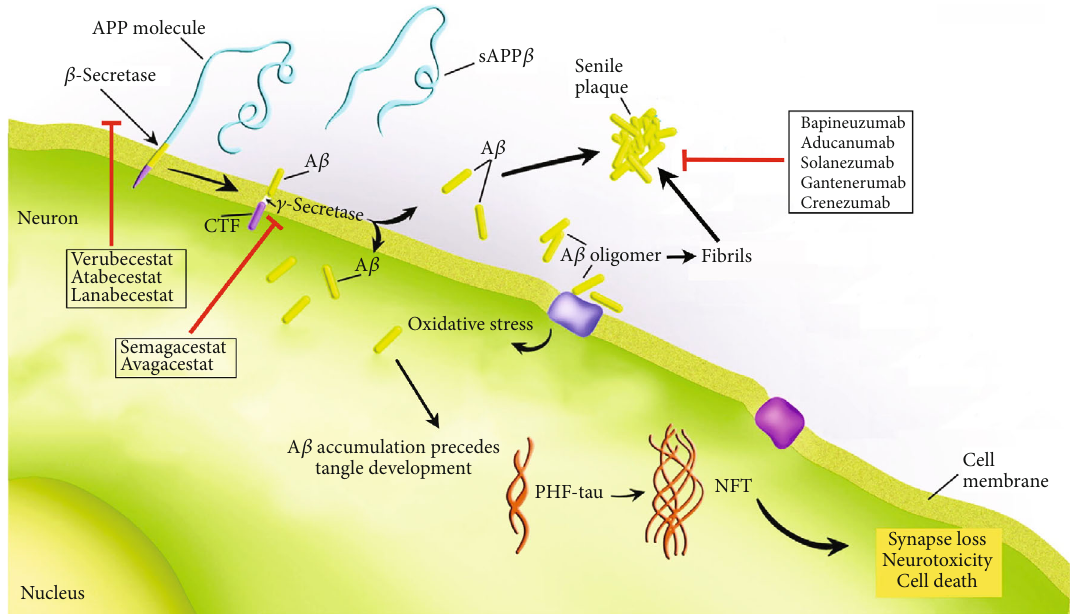
Figure 2: The A β cascade and potential therapeutics that have recently failed in human clinical trials. A highly schematic drawing illustrating the main steps involved in A β production and deposition as thought to occur in the AD brain. Production begins following cleavage of APP by β - or γ -secretases followed by the formation of oligomers and fi brils that eventually deposit into extracellular plaques. Broadly, therapeutics shown are targeted to either A β formation or clearance mediated by microglia. In addition, the connection of A β to eventual synapse loss and cell death is linked through tangle